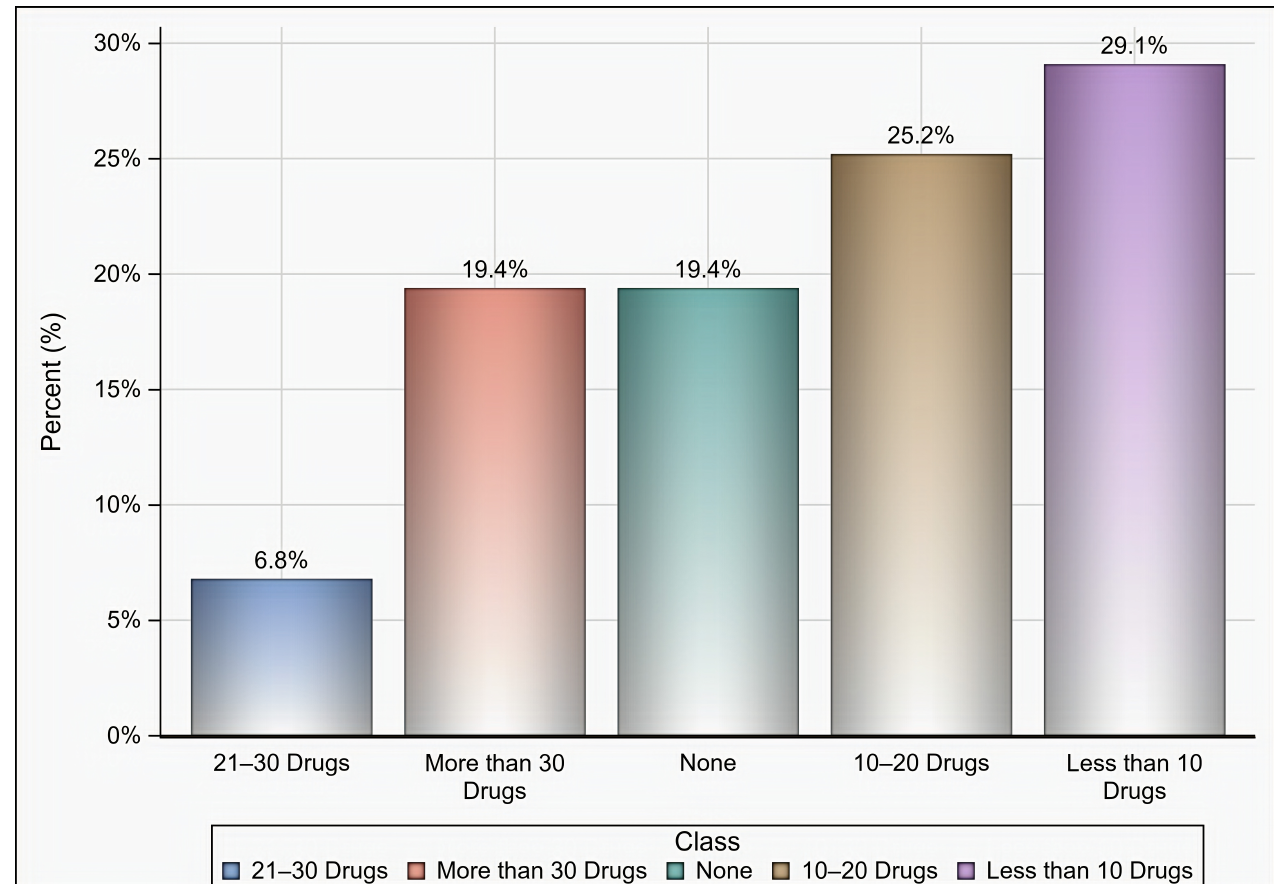
Figure 1. The number of drugs in shortage based on participants’